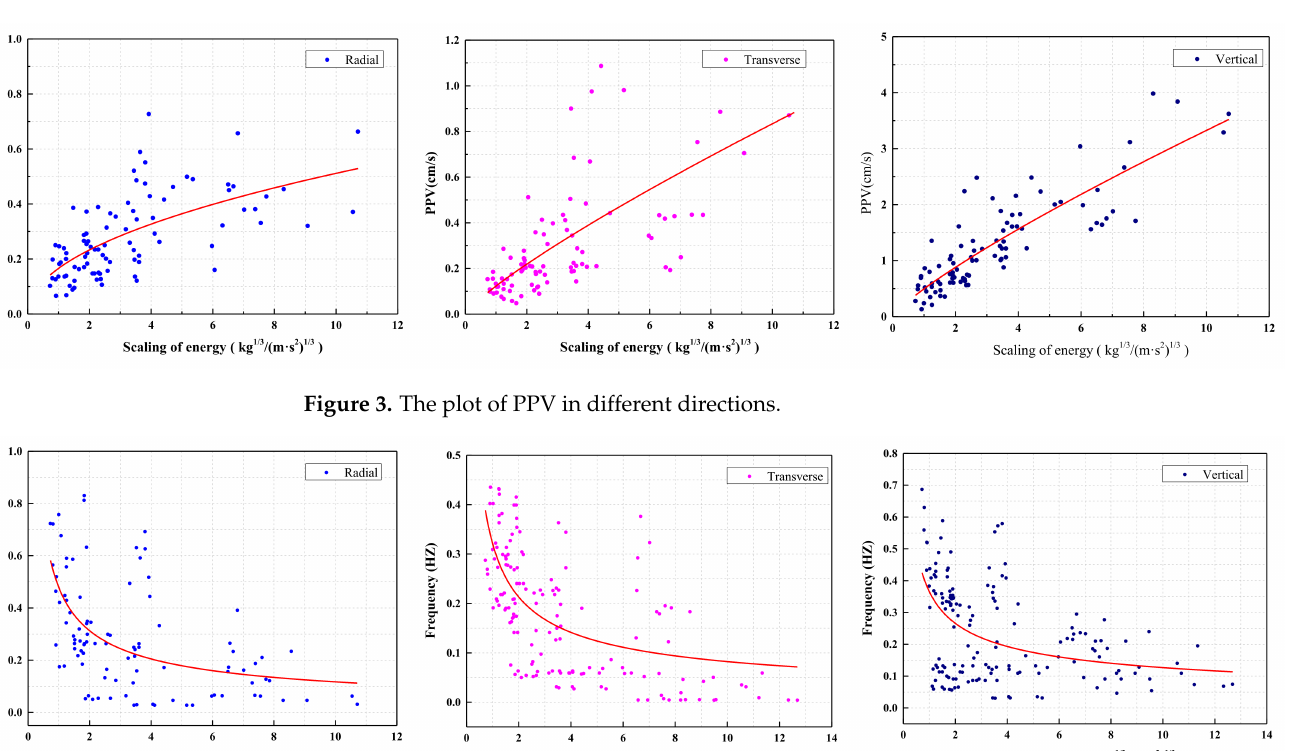
Figure 4. The plot of frequency in different